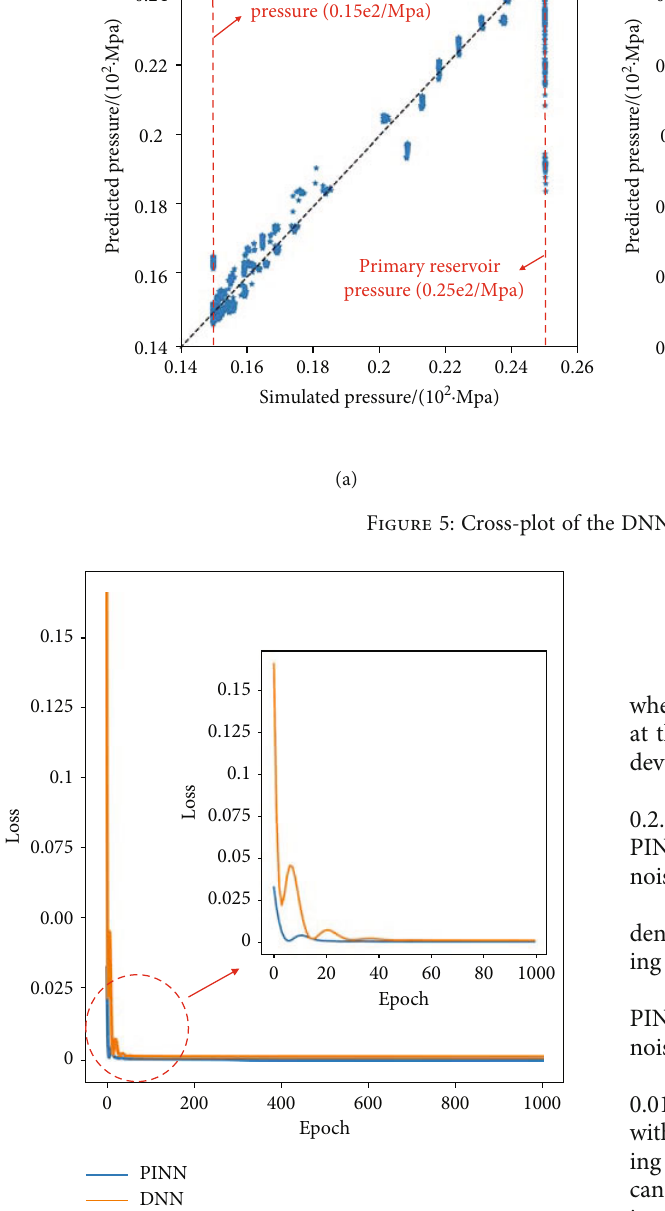
Figure 6: Convergence of the DNN and PINN